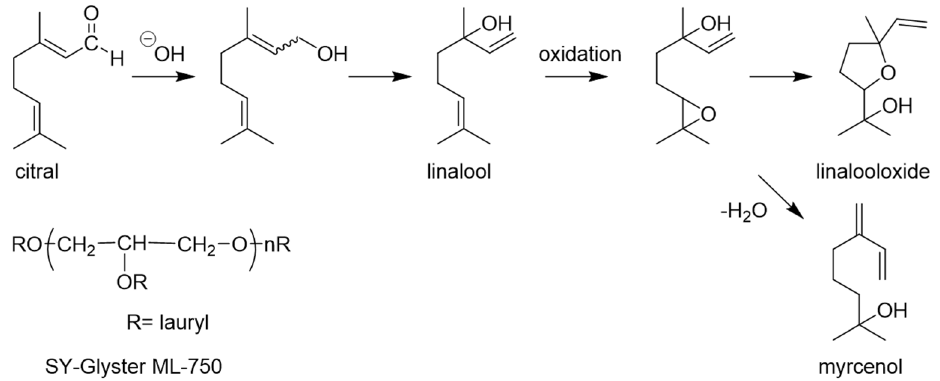
Figure 4. Formation route of deteriorated substances myrcenol and linalool oxide.